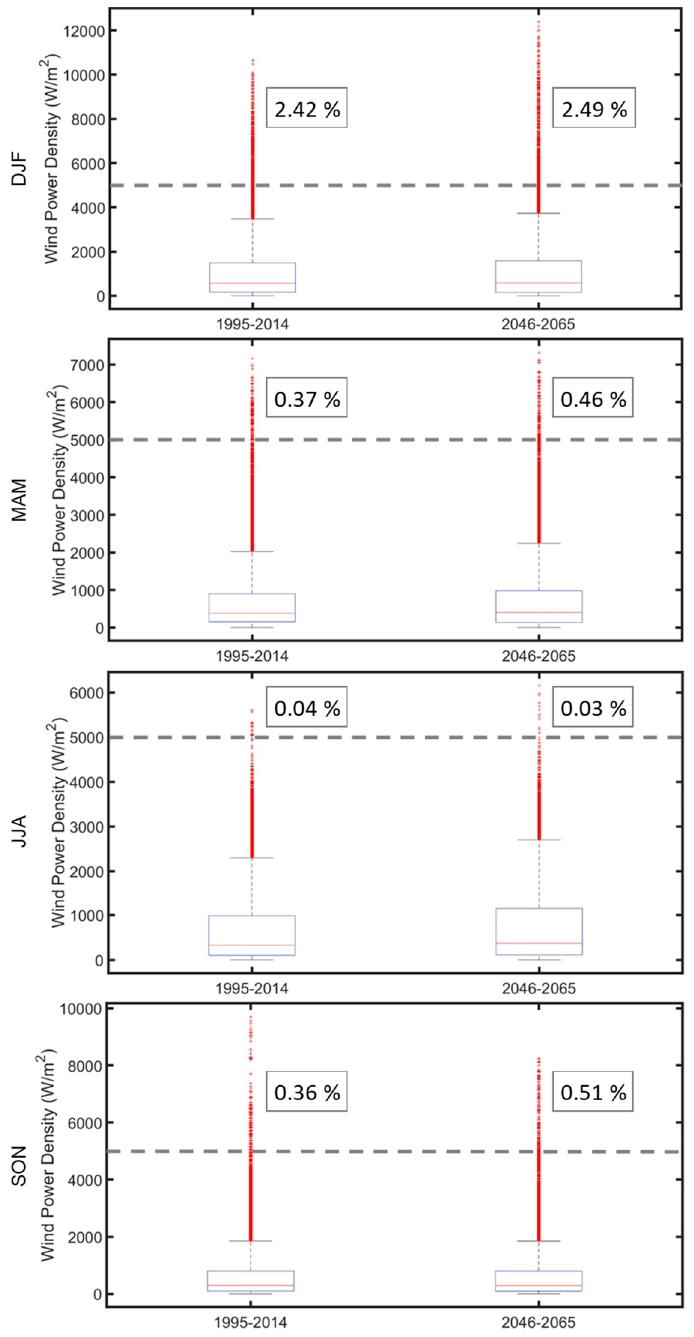
Figure 7. Seasonal (winter: DJF, spring: MAM, summer: JJA, and autumn: SON) daily variability of 100 m WPD off the coast of Viana do Castelo for the 1995–2014 reference period (left side) and 2046–2065 period (right side), under SSP5-8.5. The boxes indicate the percentage of WPD values above 5000 W/m 2 (marked with dashed lines).